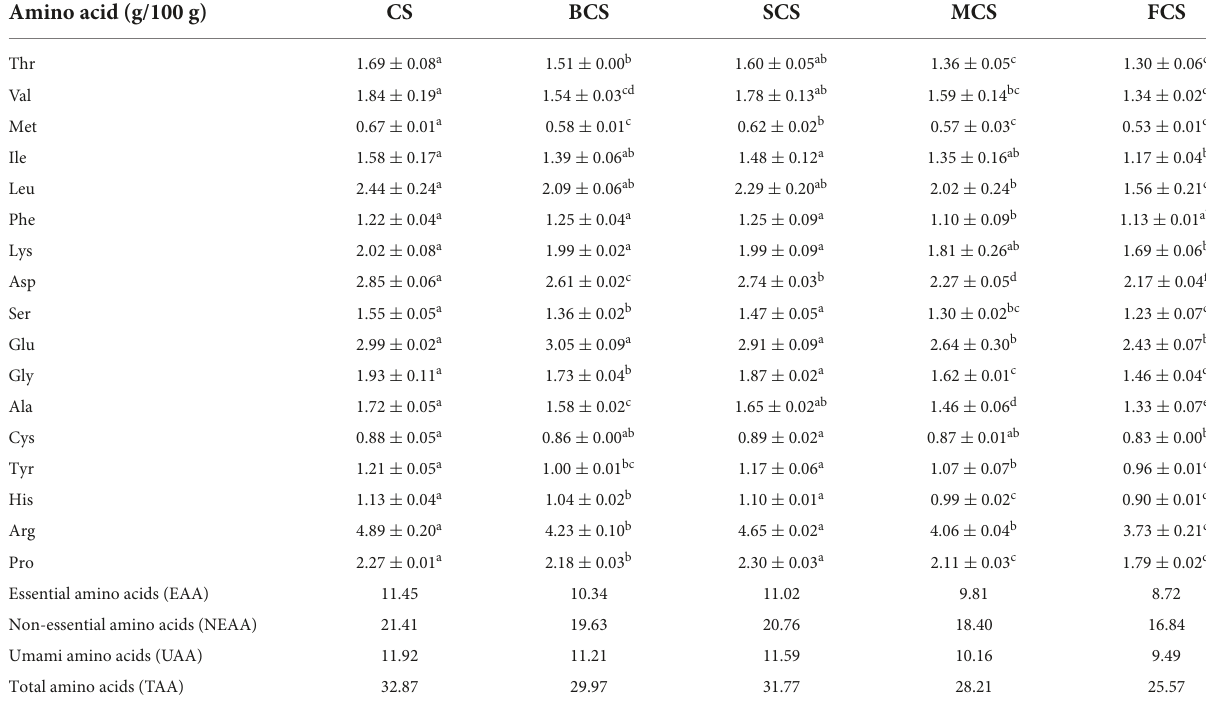
TABLE 5 Effects of different cooking methods on the hydrolytic amino acids in C. squamulosa. Amino acid (g/100 g)